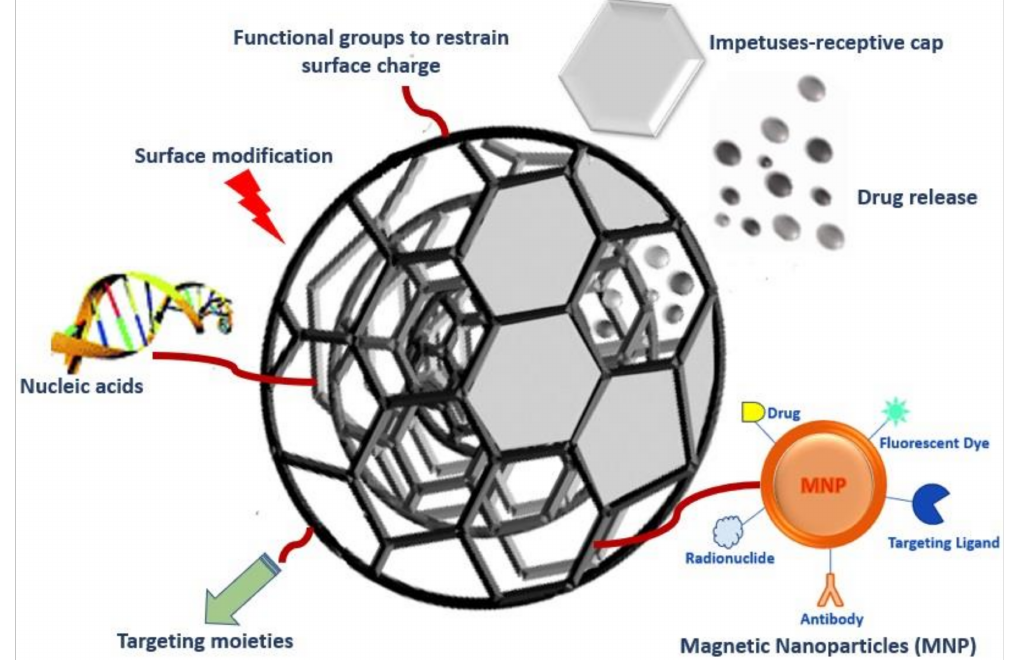
Figure 9. Graphic illustration of carbon nano-onions (CNOs) functionalization and applications. Adapted from